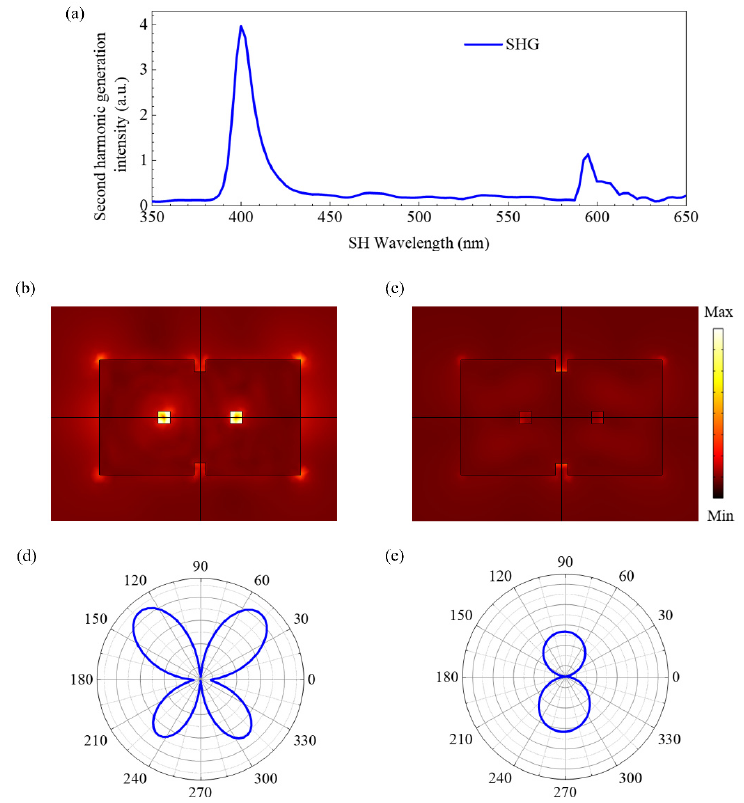
Figure 6. ( a ) The SHG intensity of the OH-SiNB. Near-field electric field distribution of SHG in the xoz plane at ( b ) λ SHG 1 = 400 nm and ( c ) λ SHG 2 = 595 nm. Angular plots of the SH far-field radiation in the yoz plane at ( d ) λ SHG1 = 400 nm and ( e ) λ SHG2 = 595 nm.